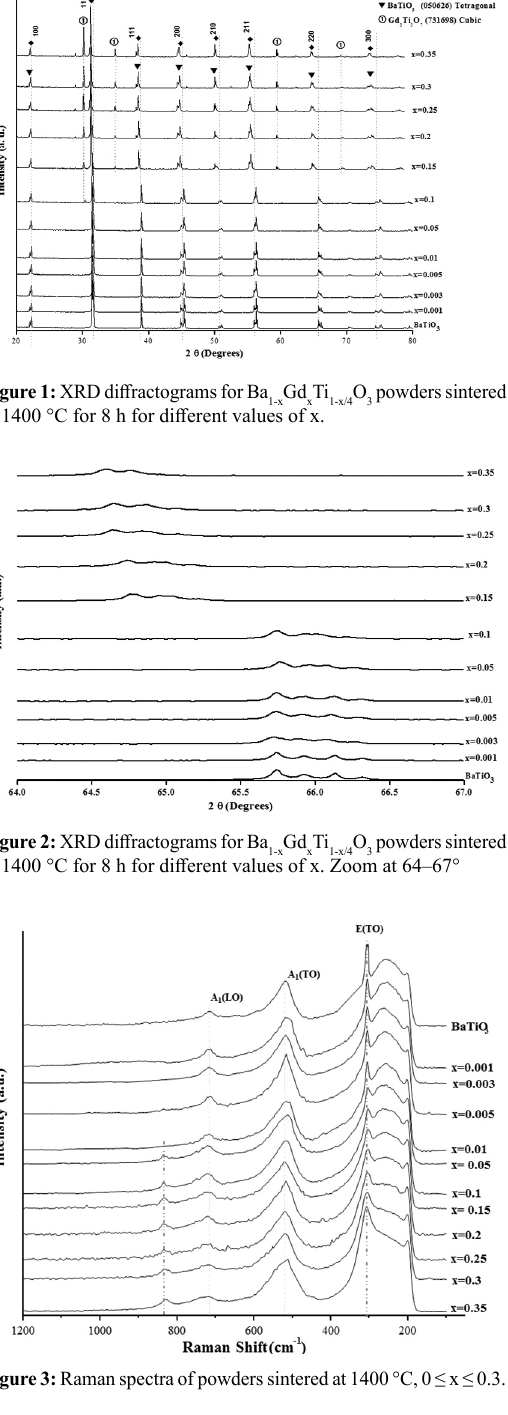
Raman peak around 304 cm -1 showed a decrease in intensity. This diminution was attributed to the decrease of tetragonality of BT ceramics. The phase transformation was observed in DRX results when Gd 3+ content was x ≥ 0.35 (Figure 1) and dielectric measurements.